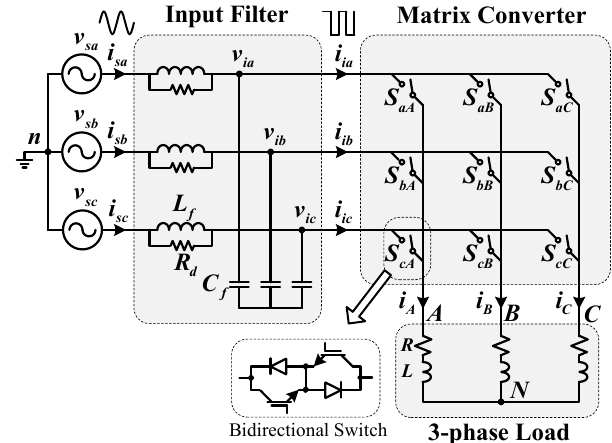
Figure 1. A common matrix converter configuration.